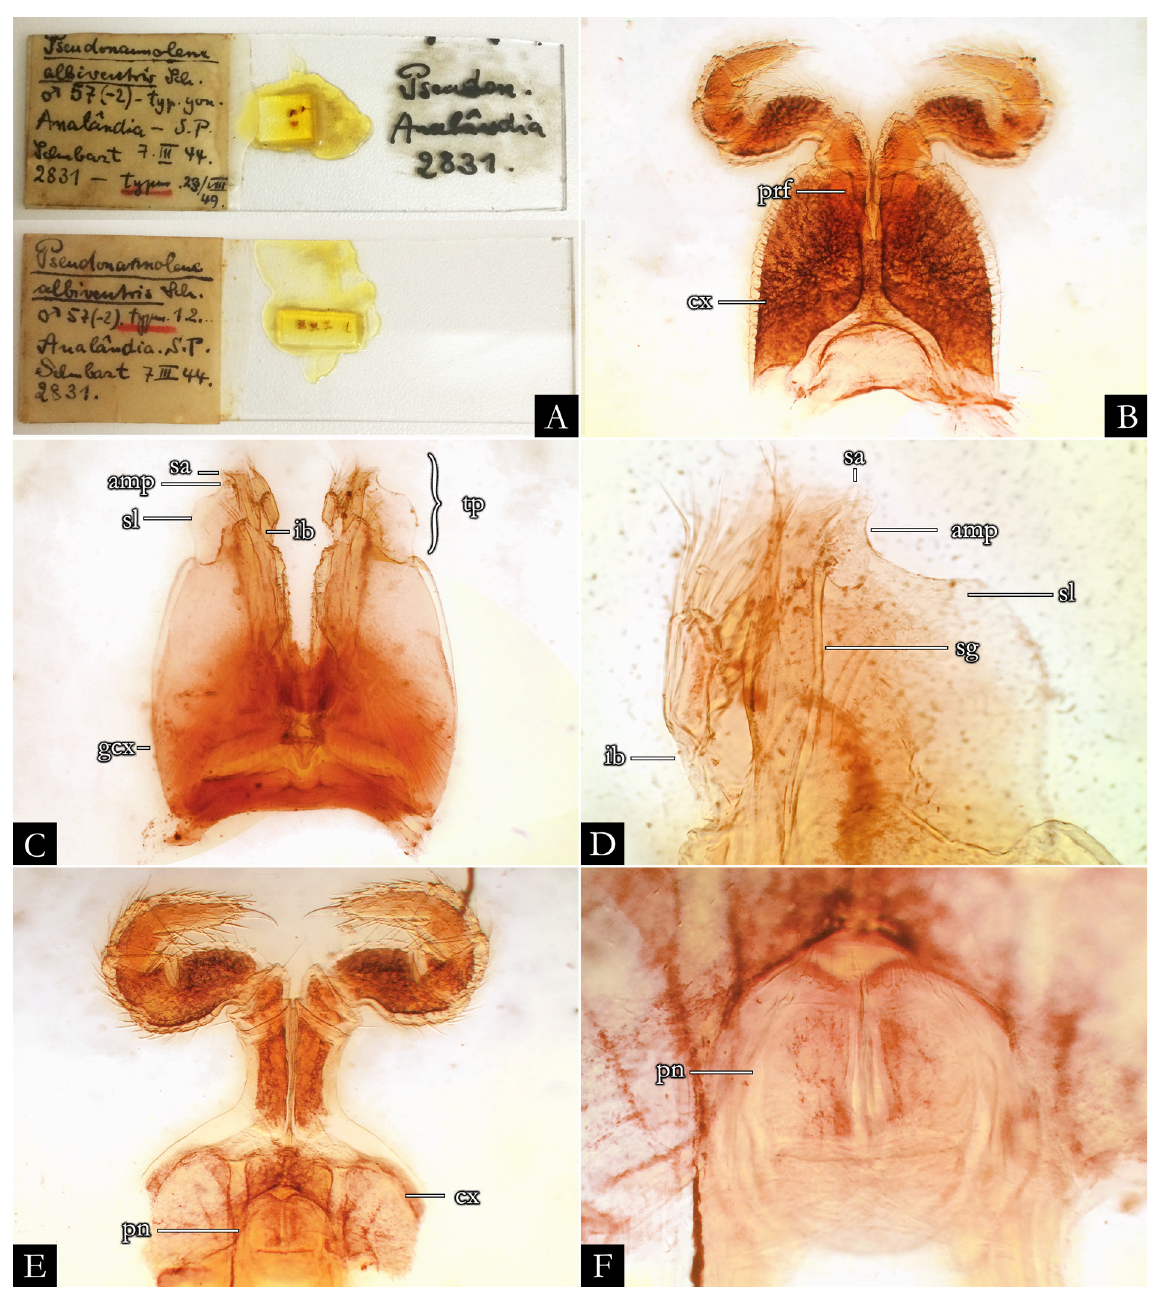
Fig. 43. Pseudonannolene albiventris Schubart, 1952, ♂ (MZSP). A . Sexual structures and gnathochilarium of type material mounted on microscope slide. B . First leg-pair. C . Gonopods, in oral view. D . Detail of telopodites, in oral view. E . Second leg-pair. F . Detail of penis. Abbreviations: see Material and methods. Images not to